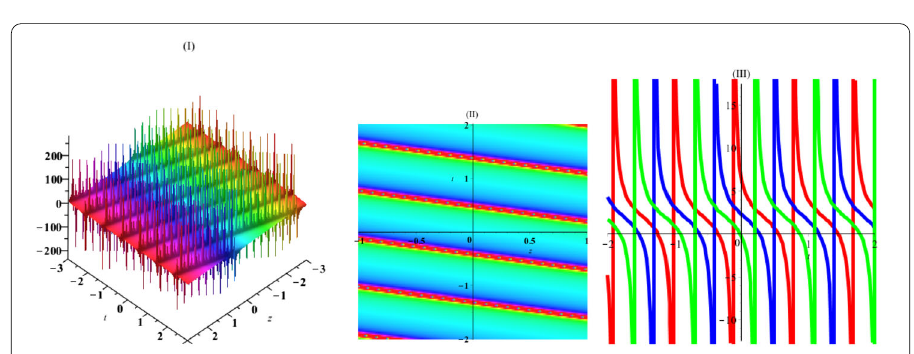
Figure 4 The plot of solitary (13) with amounts c 0 = 2, c 1 = 1, c 2 = 1, c 3 = 1, c 4 = 1, c 5 = 1, x = 1, y =